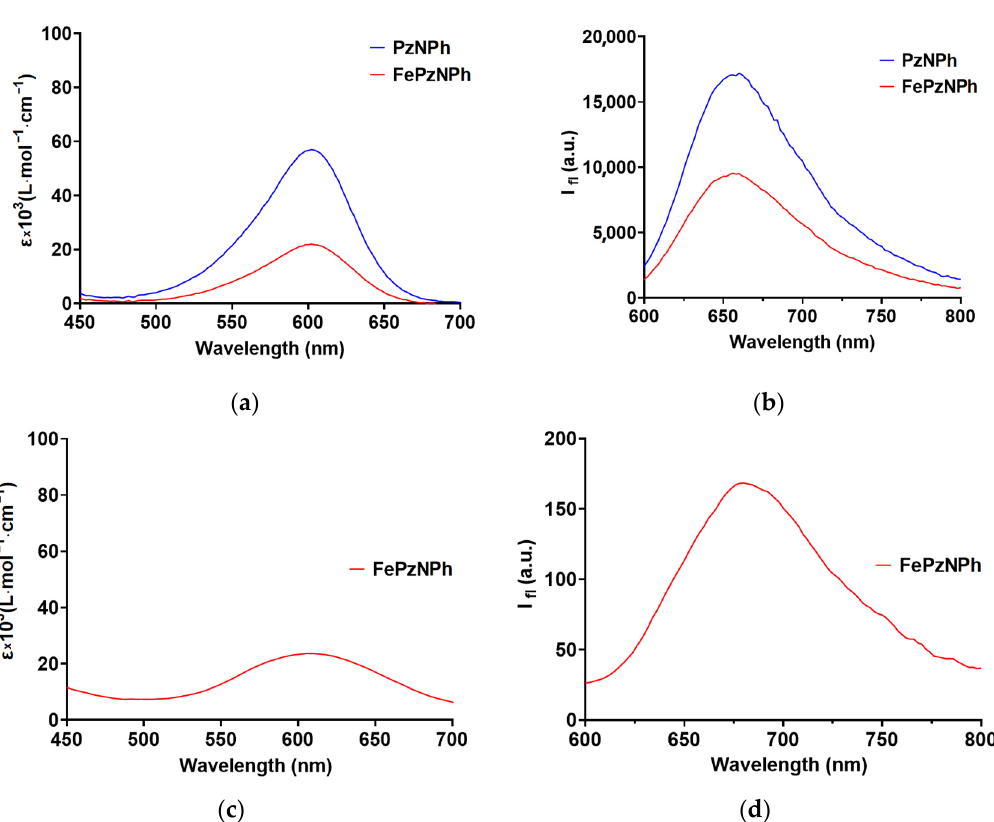
Figure 2. Absorption and fluorescence spectra of PzNPh and FePzNPh in glycerol ( a , b ) and in water ( c , d ) (both at 5 µM). The fluorescence was excited at λ ex 570 nm. Table 1. Spectral properties and fluorescence quantum yield of PzNPh and FePzNPh . H 2 O Compound